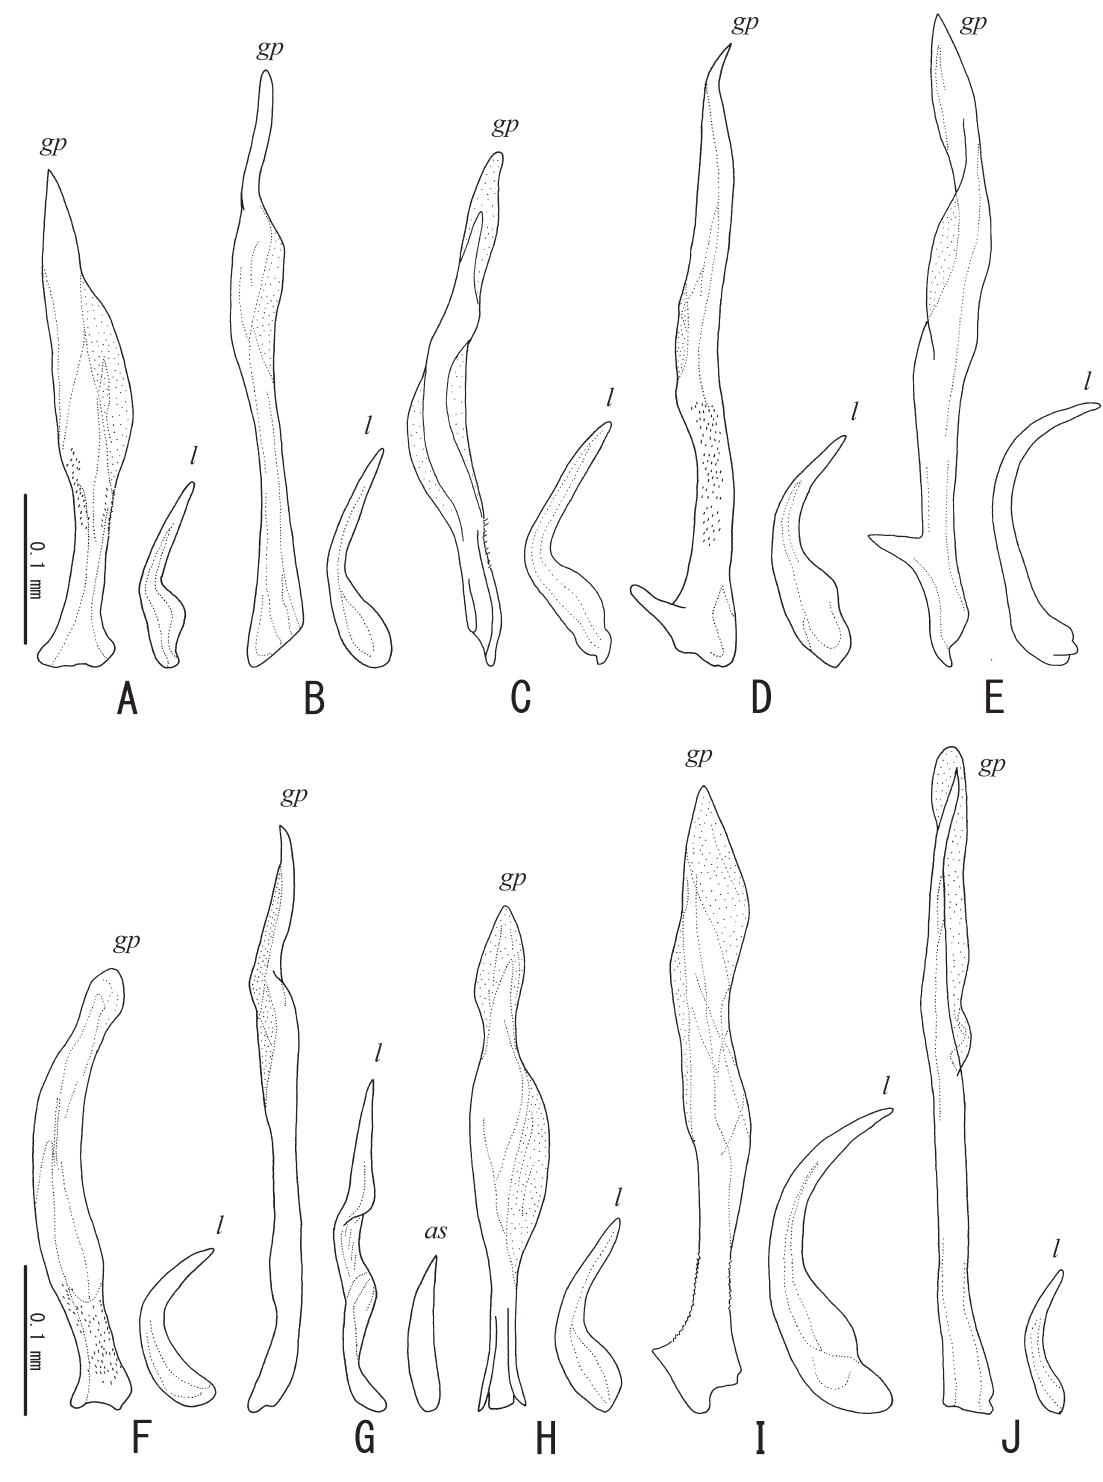
Fig. 3. Endophallic sclerites of Laius spp. A . Laius baliensis sp. nov. (paratype). B . L. andamanensis sp. nov. (paratype). C . L. rodriguesensis sp. nov. (paratype). D . L. maai Wittmer, 1973 (paratype). E . L. marchei Pic, 1922. F . L. politus Fairmaire, 1880. G . L. sabangensis Wittmer, 1985 (paratype). H . L. sericatus Champion, 1924. I . L. submariniformis Wittmer, 1985 (paratype). J . L. asahinai Nakane,